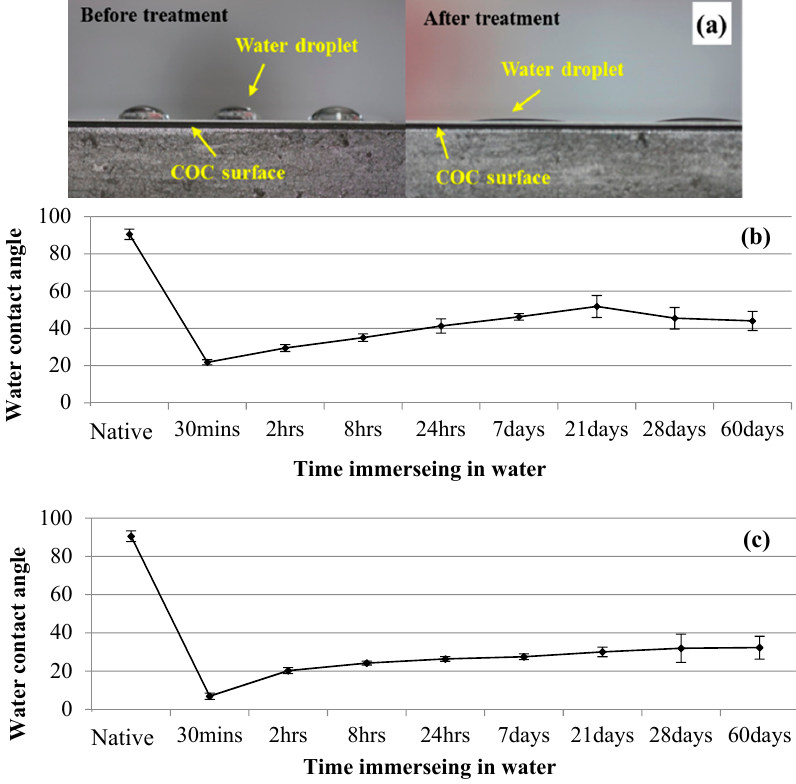
Figure 3. ( a ) Change in the COC-surface wettability after UV/Ozone treatment. The COC-surface water contact angle at different water-immersion times after ( b ) 100 s and ( c ) 300 s of UV/Ozone surface treatments.